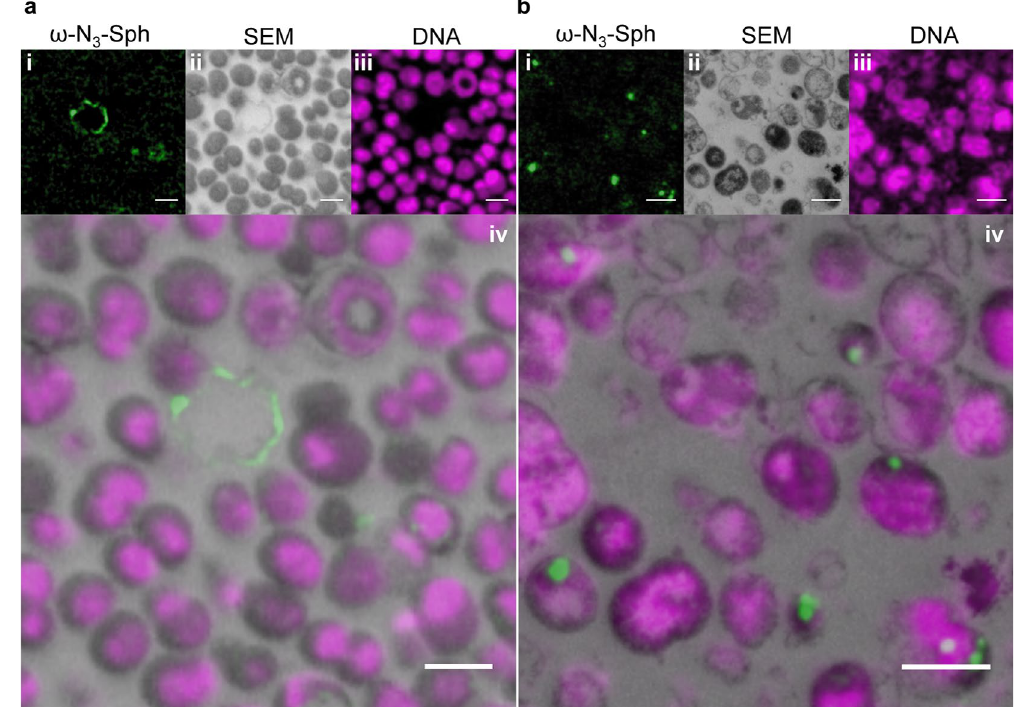
Figure 4. Click-AT-CLEM strategy reveals localization of ω-N 3 -Sphingosin in N. meningitidis . ( a , b ) Representative CLEM images of N. meningitidis treated with 0.1 × MBC ( a ) or 1 × MBC ( b ) of ω-N 3 - Sphingosine. Upper rows show representative single images of the ω-N 3 -sphingosine [ω-N 3 -Sph (green)] and DNA signal (magenta) taken with SIM ( i , iii ) and N. meningitidis image taken with SEM ( ii ). Final images after unbiased correlation are shown in ( iv ). Scale bars 1 µm.